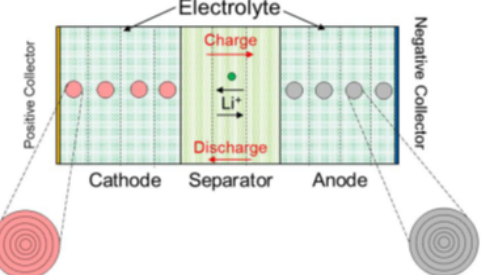
Figure 18. Cross-Sectional representation of Pseudo-2D model of a lithium-ion cell [33]. Reprinted with permission from Ref. [33]. Copyright 2022 Gamma Technologies,